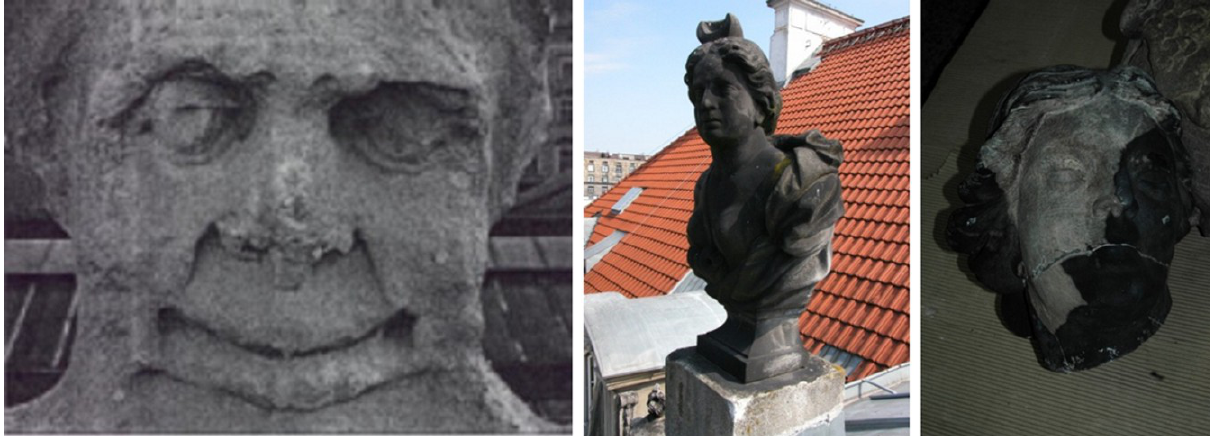
Figure 1. Illustration of destructive influence of acid rains on sandstone sculptures: a) Drapper’s Hall in Cracow (1995); b) bust at Czapski Palace, Warsaw, seat of Academy of Fine Arts; c) woman’s head during laser